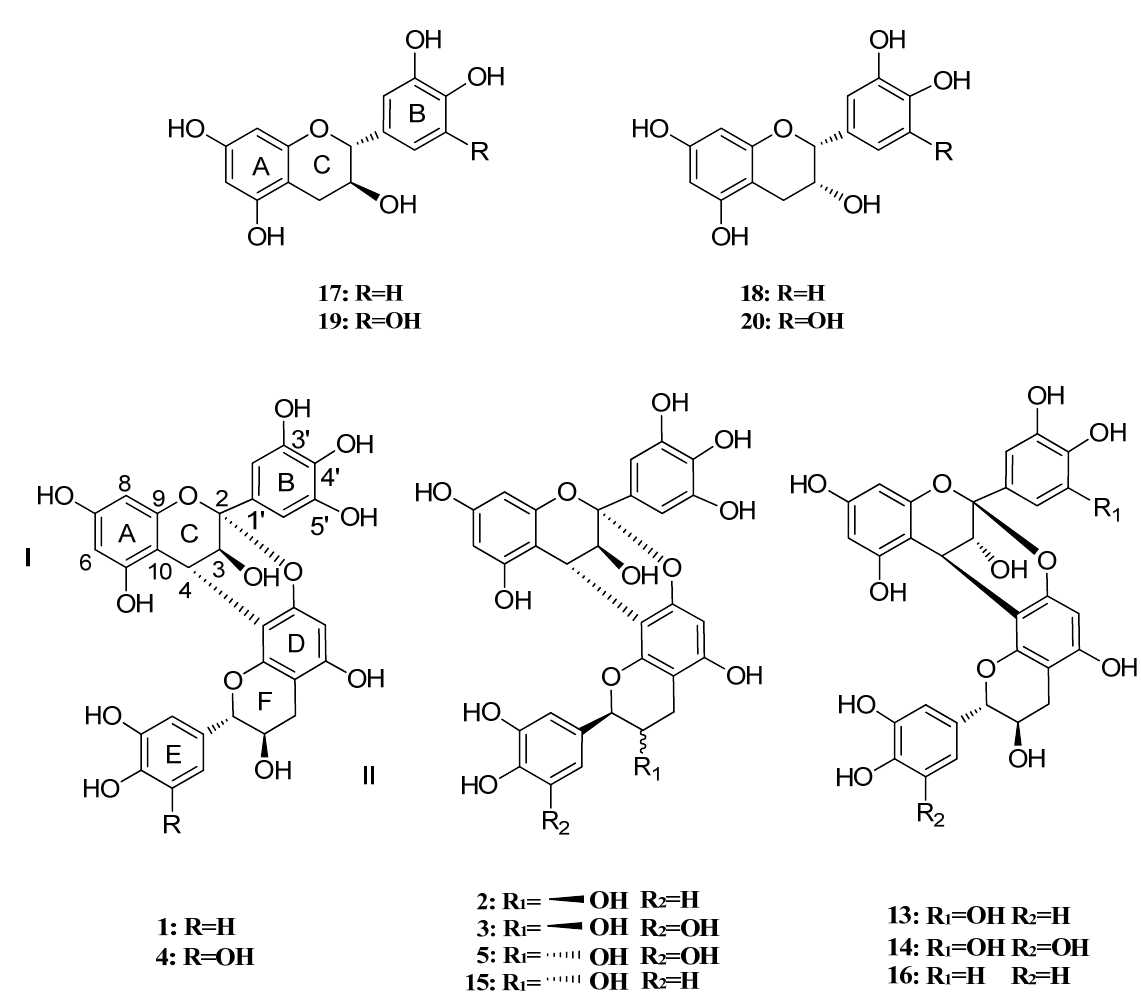
Figure 1. The chemical structures of compounds 1 – 20